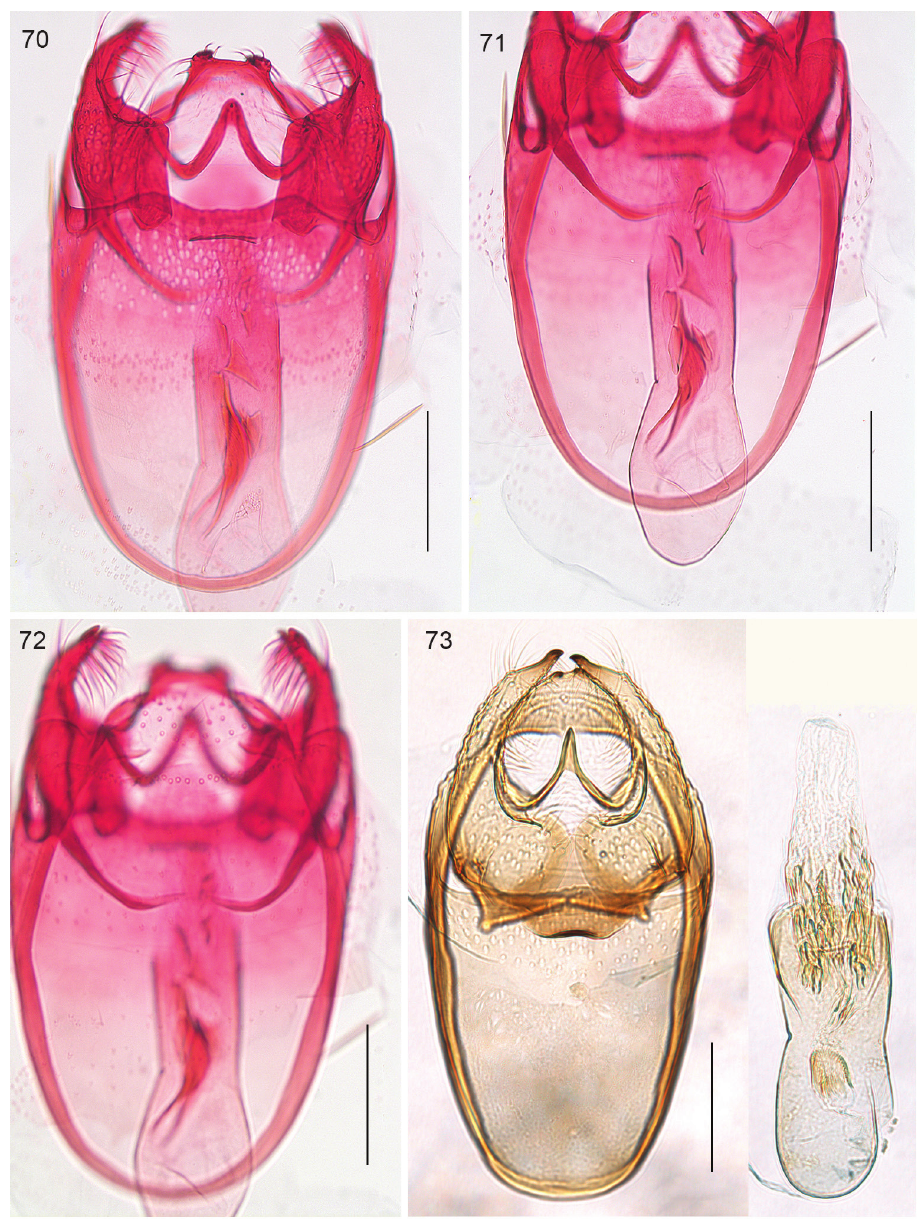
focus 73 O. ovata , holotype. Scale bars: 100 µm. on host plant leaf, next to leaf veins or vein grooves either on upper or underside leaf (n=20) (Figs 88, 92). A species of a solitary koinobiont-endo parasitoid wasp was found inside the inner chamber of cocoon